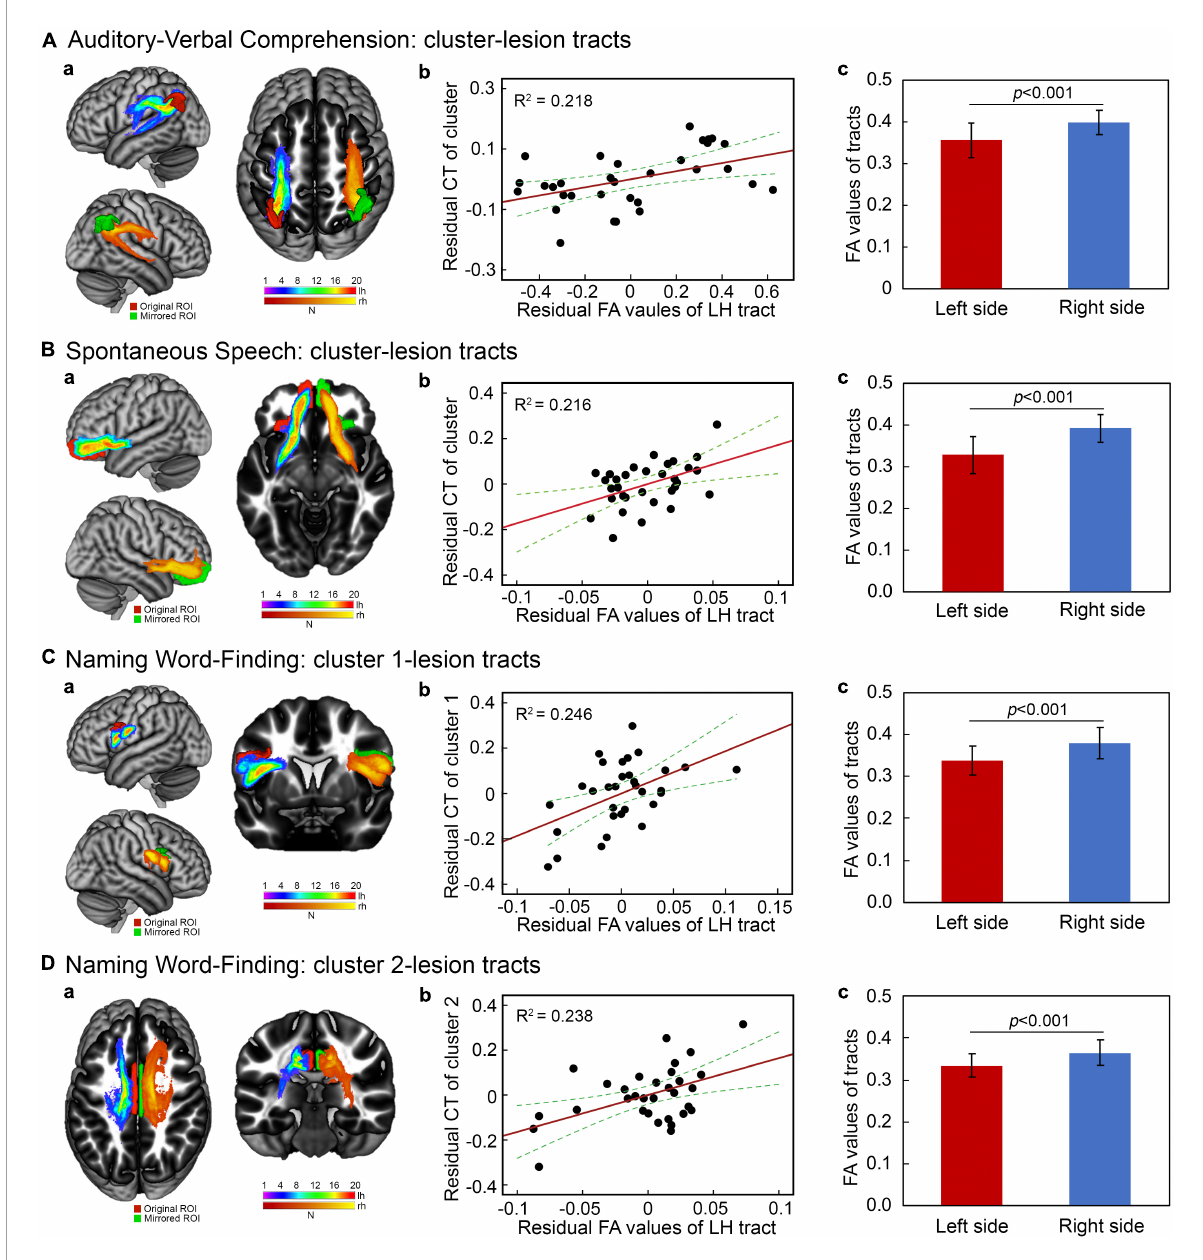
FIGURE3 Integrity of white matter tracts related to cortical thickness in connecting brain regions. (Aa–Da) Reconstruction of fiber tracts connecting stroke lesions to cortical regions of interest (red) and the corresponding fiber tracts with mirrored stroke lesions and cortical regions related to language performance. Violet–red indicates the left hemisphere tracts and red–yellow indicates the mirrored tracts. All fiber tracking was thresholded at 1% of overall connectivity. (Ab–Db) Partial correlations between mean fractional anisotropy (FA) values of left fiber tracts and the corresponding cortical thickness measures when controlling for demographic variables and lesion size. (Ac–Dc) Paired comparisons of mean FA values of the left fiber tracts relative to their mirrored tracts (all P <